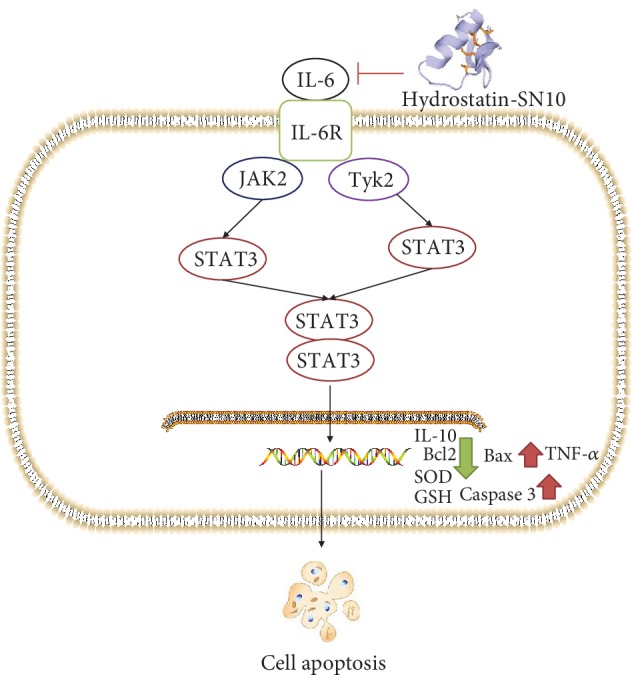
Schematic diagram of the effects of hydrostatin-SN10 on the JAK2/STAT3 signaling pathway. Hydrostatin-SN10 exerts its anti-inflammation and antioxidant properties via IL-6-induced JAK/STAT3 signaling pathway. IL-6 binds to the IL-6 receptor on the cell membrane. The complex of IL-6 and IL-6R interacts the JAK2 and activates transcription factors of the signal transducers and activators of STAT3 and initiates JAK2/STAT2 signaling. STAT3 is phosphorylated and then forms dimers with other STAT. The activated STAT3 complex will then enter into the nucleus initiating or inhibiting transcription of its regulating genes (including inflammatory cytokines, oxidative stress, and apoptosis factors), resulting in the changes of cell apoptosis.